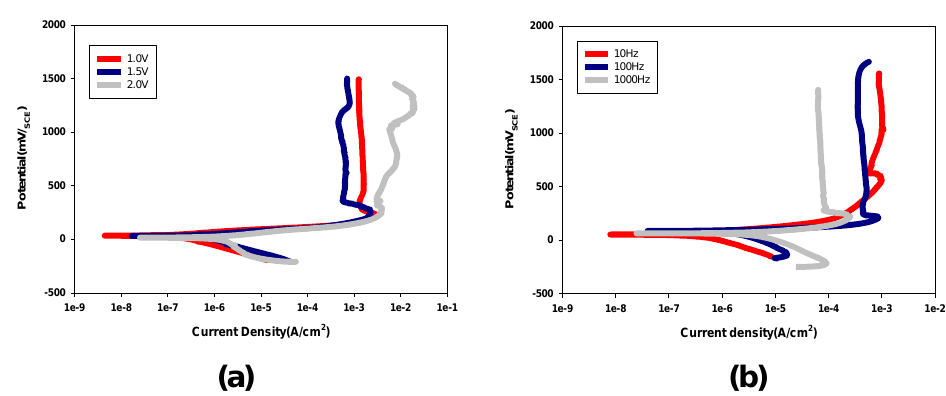
Figure 3. Potentiodynamic polarization curves for Au coated PCB substrates formed by ( a ) a DC electroplating method with various applied potential and ( b ) a pulse electroplating method at various frequencies.